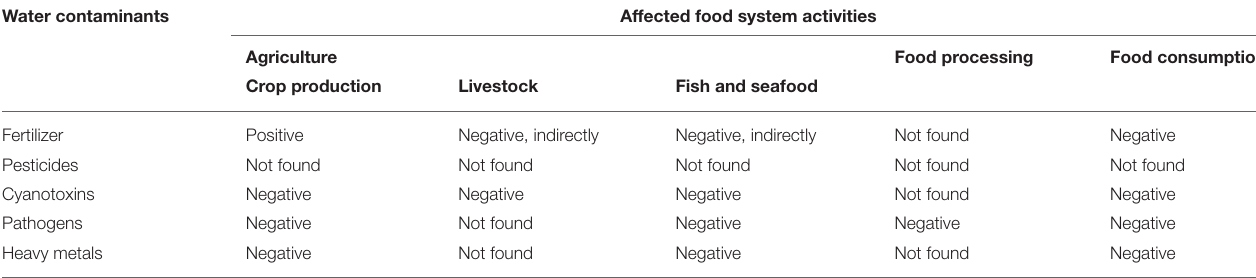
TABLE 4 | Impacts of water contaminants on food system activities.